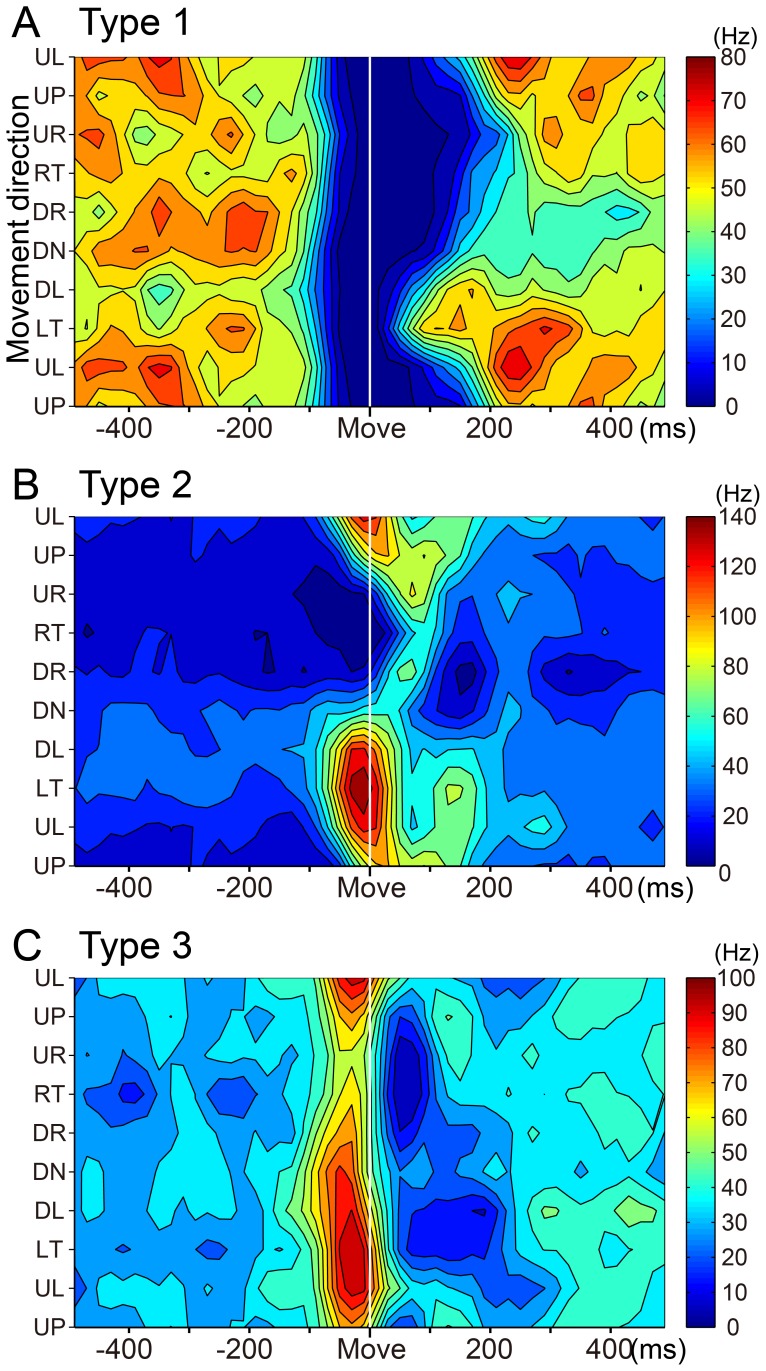
Contour plots of three types of DN cell activity.Spatiotemporal maps of neuron activity of type 1 (A), type 2 (B) and type 3 (C) DN cells in relation to 8 movement directions for the same cells illustrated in Figure 10. These plots were generated with MATLAB. Color code was adjusted according to the maximum firing rate in each DN cell.